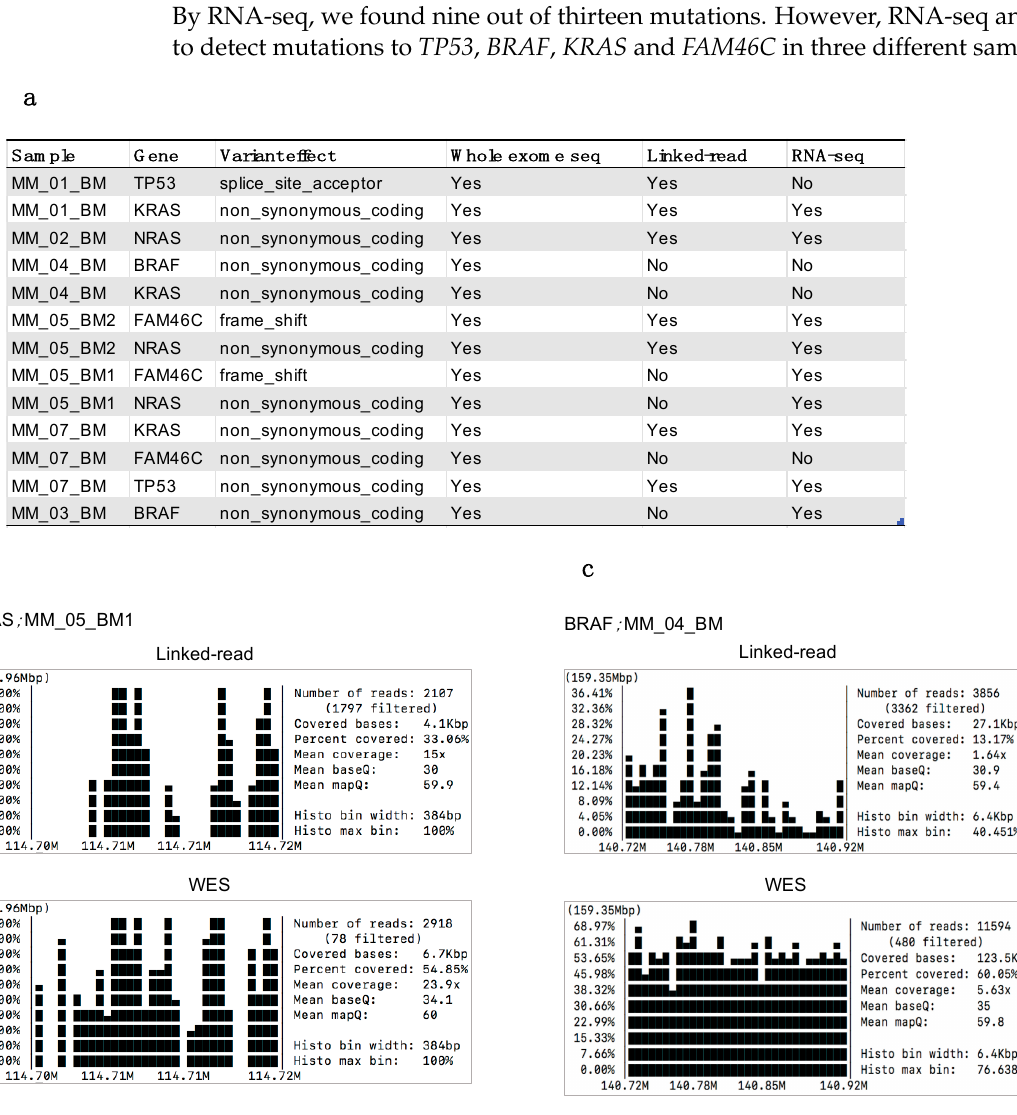
Figure 7. ( a ) List of myeloma-specific somatic mutations detected by whole-exome sequencing, linked-read and RNA-seq. ( b , c ) Gene coverage plots generated using SAMtools depicting NRAS in MM_05_BM1 and BRAF in MM_04_BM sample in linked-read and WES data.